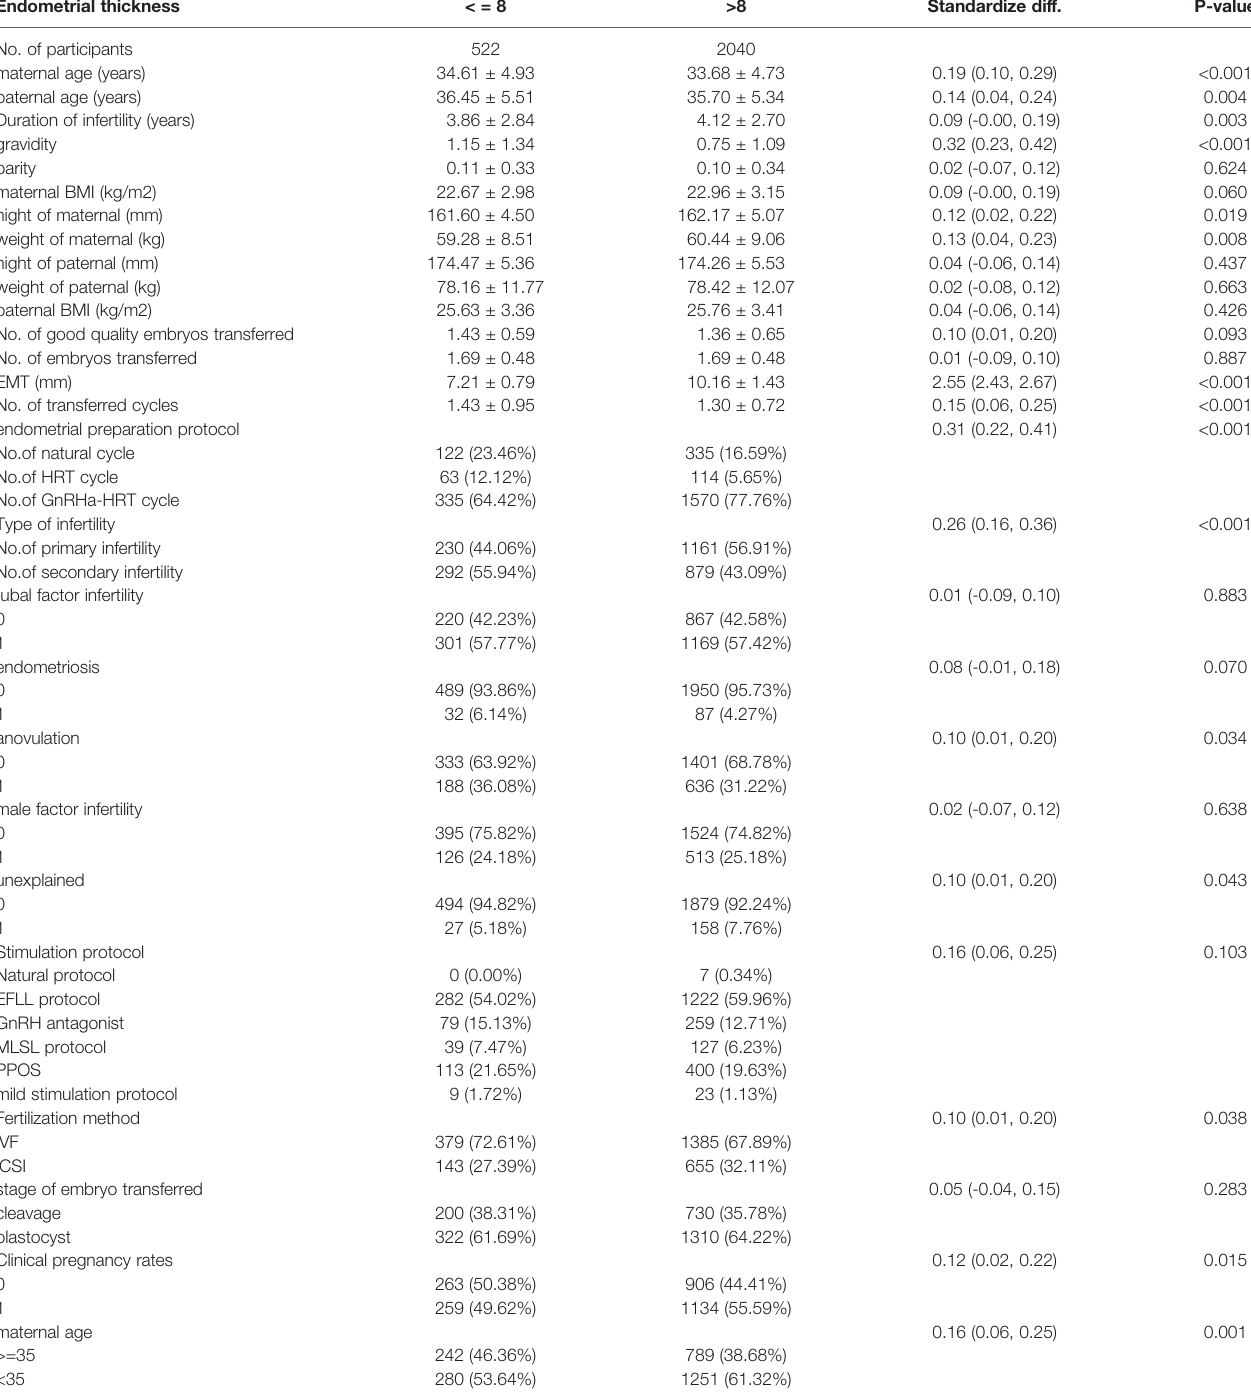
TABLE 1 | Baseline characteristics of the